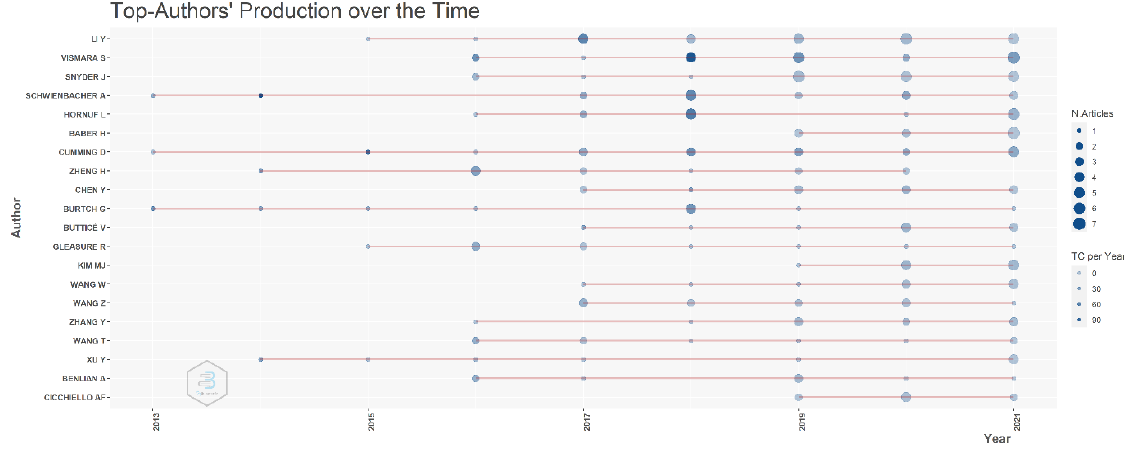
Figure 2. Authors’ publications.